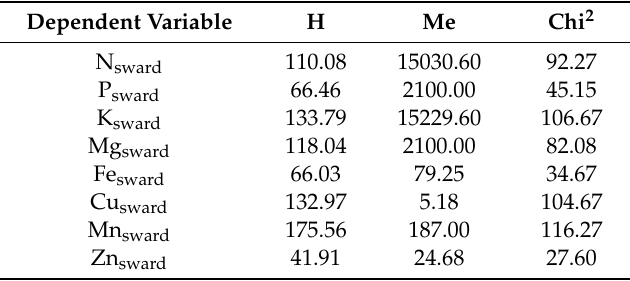
Table 4. Results of the Kruskal–Wallis test (H) and median test (Me); df = 5, n = 360, element content in mg kg − 1 , independent variable plot (A–F), p < 0.001.